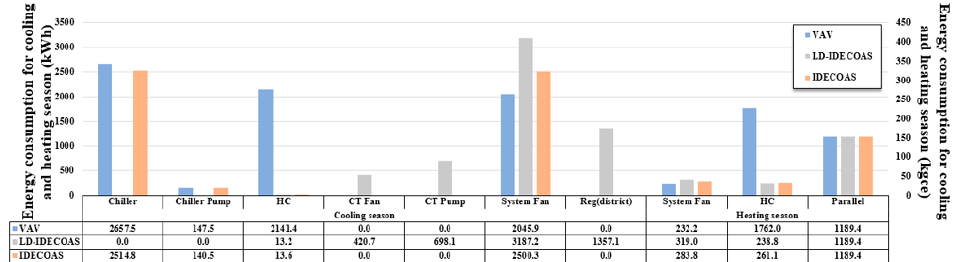
Figure 16. The seasonal energy consumption comparison in Kunming.